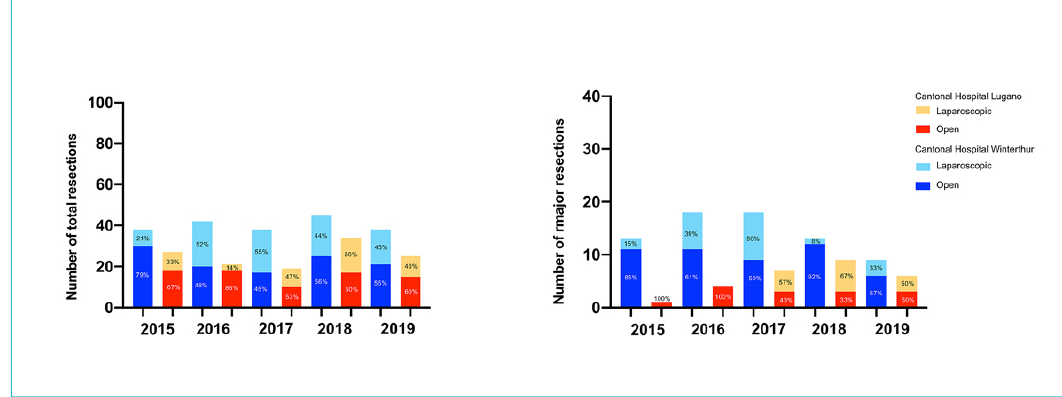
Figure 1: Number of total and major liver resections per year.